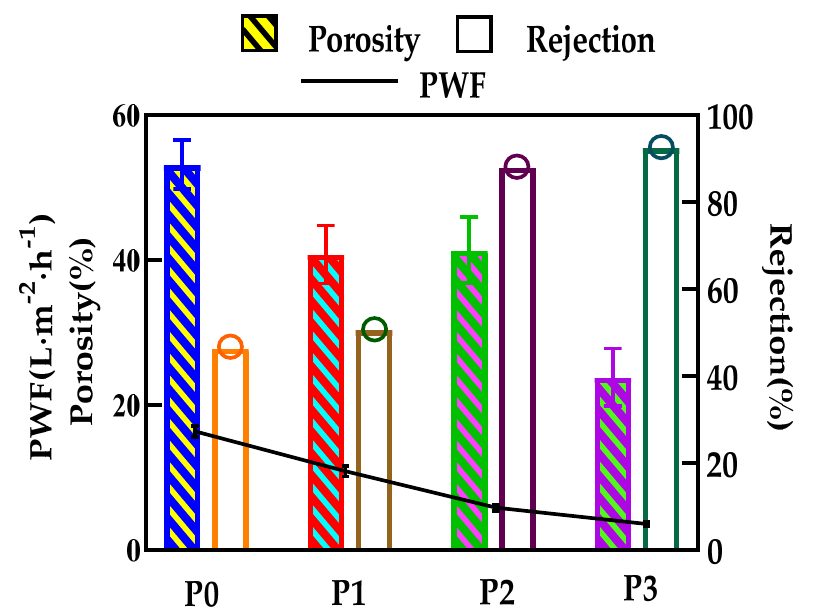
Figure 14. Pure water flux, porosity and rejection of ultrafiltration membranes with different GO doping amounts.